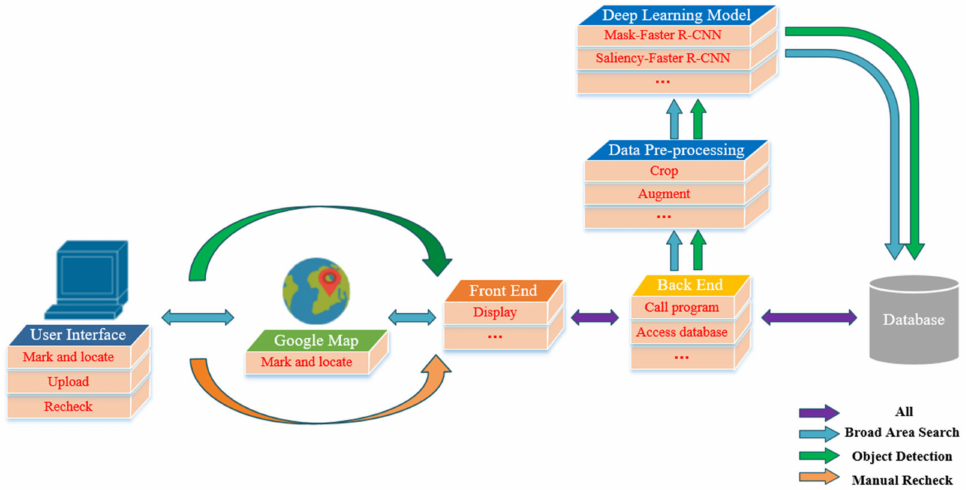
Figure 10. The architecture of the Broad Area Target Search (BATS) system with the front end established by Vue.js and the back end implemented by